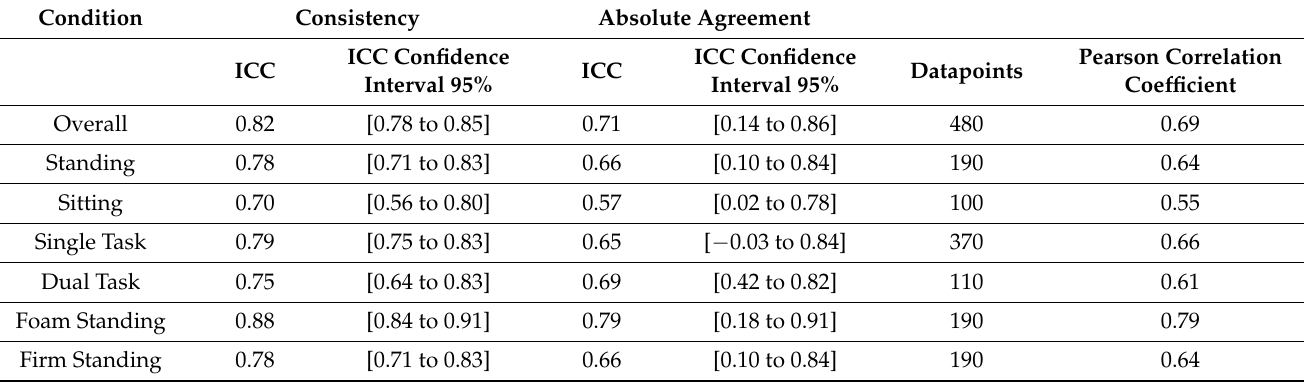
Table 1. Intraclass correlation (ICC) analysis between the camera and sensor systems. Overall, results show moderate-to-good consistency and absolute agreement between the camera-based and sensor-based systems.